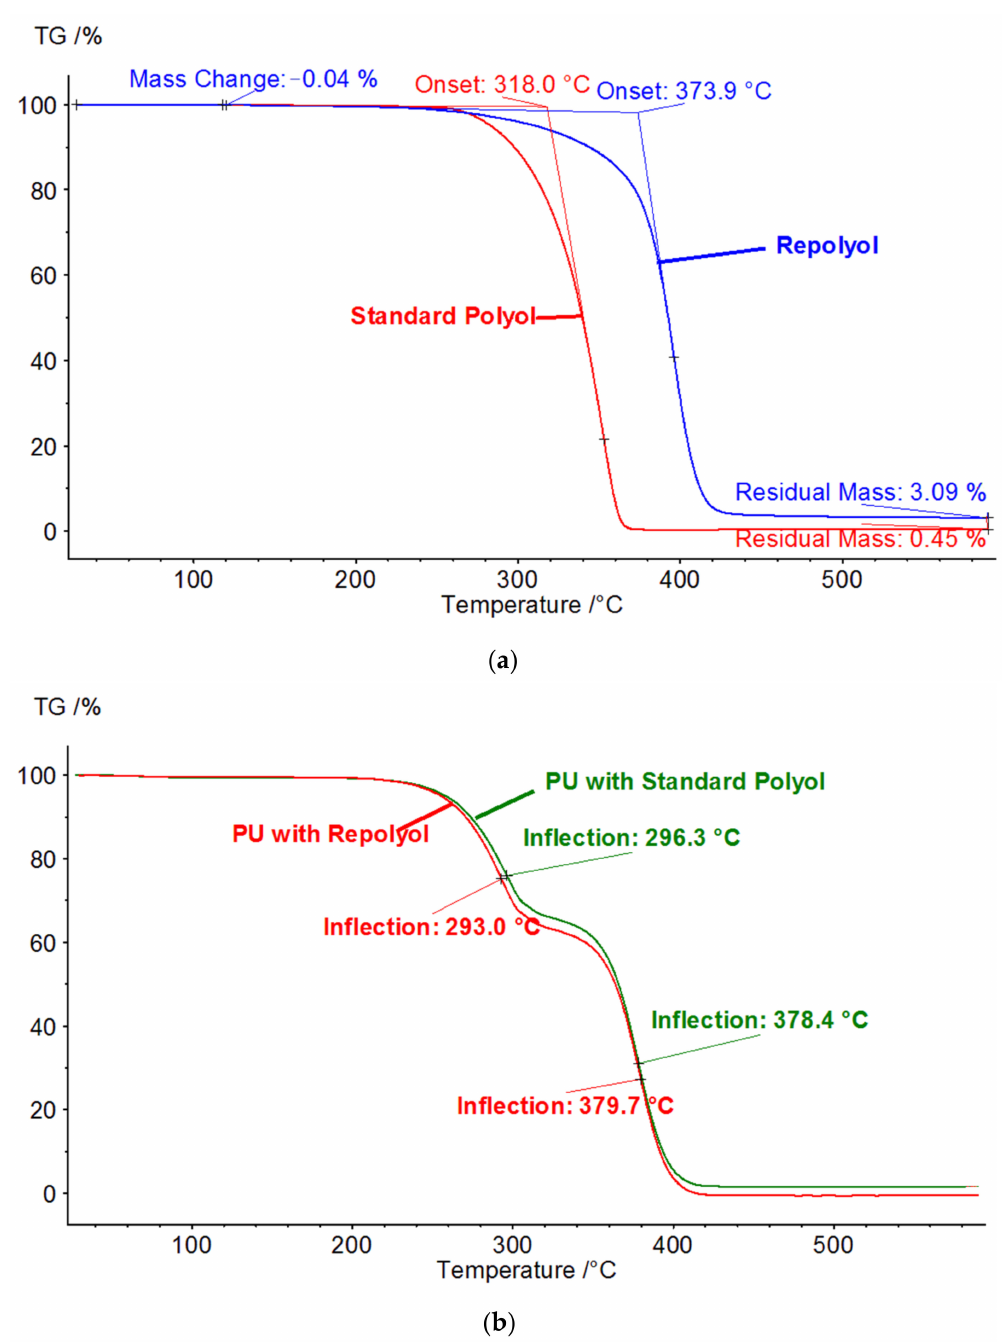
Figure 2. TGA thermograms of ( a ) Repolyol (blue line) and the reference polyol (red line) and ( b ) PU with Repolyol (red line) and PU with standard polyol (green